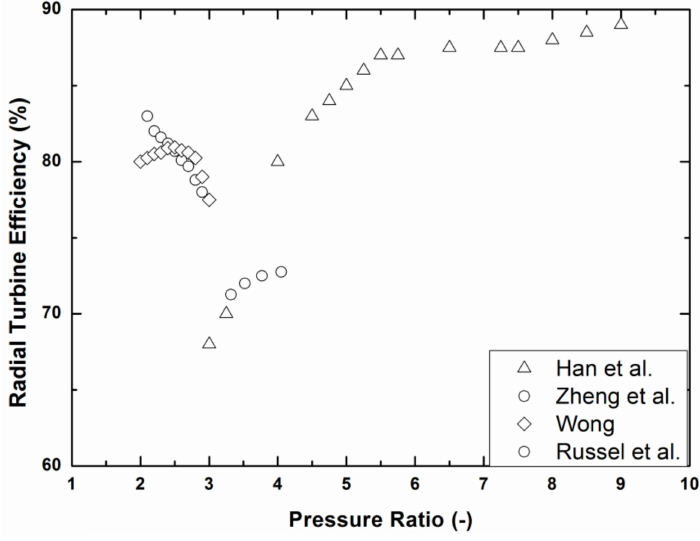
Figure 11. Performance of radial